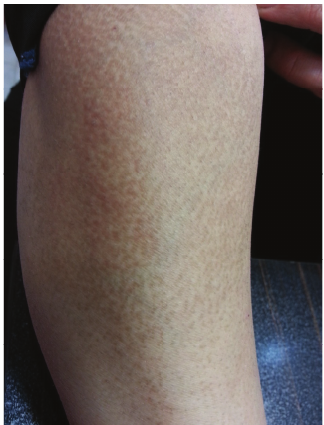
Figure 1: Hyperpigmented patch composed of small brown macules in a rippled or reticulated pattern on the arm.